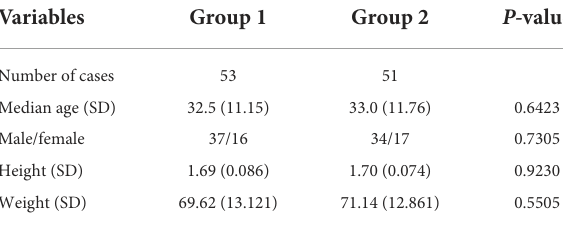
TABLE 3 Demographics data of the two groups. TABLE 4 Functional assessment: The modified Lysholm knee scoring